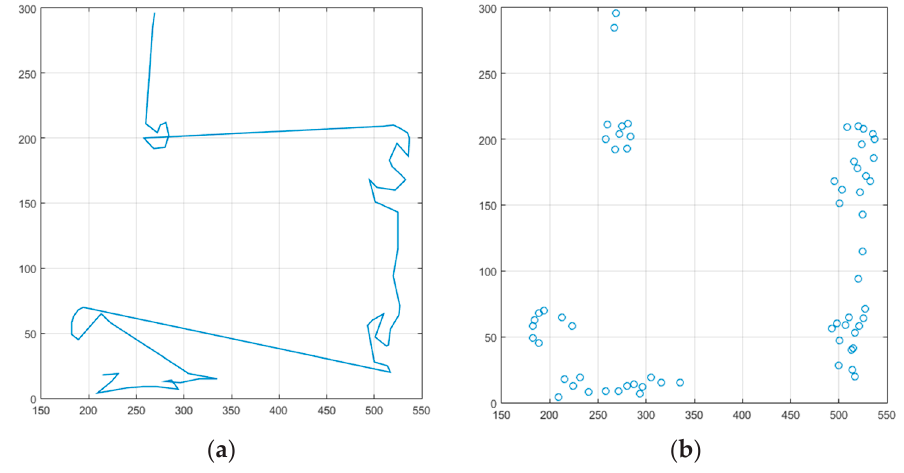
Figure 15. Eye gaze coordination for 1. Scenario (Figure 13) (2D line graph ( a ), scattered ( b )).